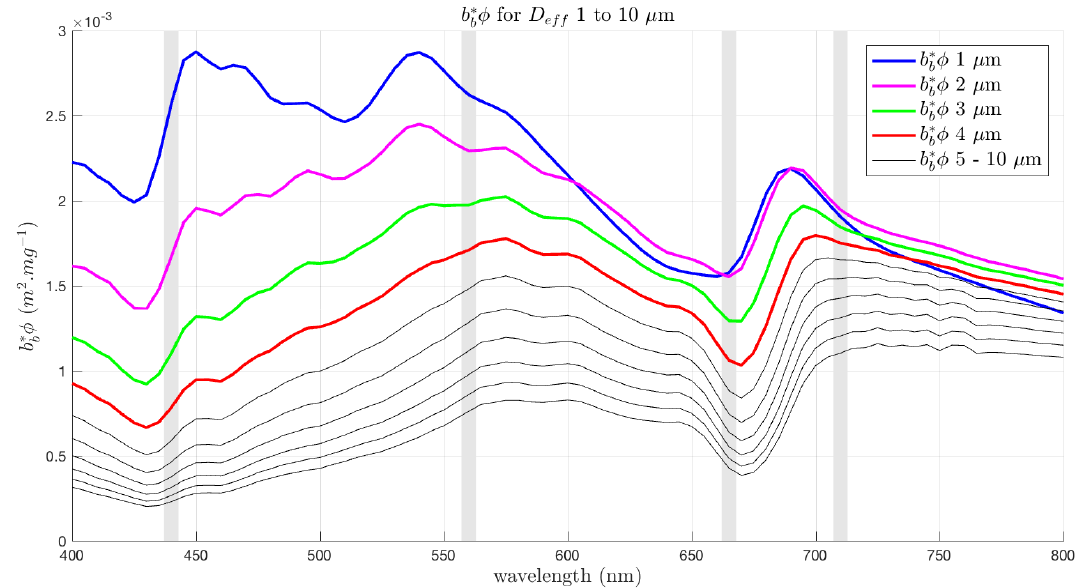
Figure 12. b ∗ φ shown for D ef f 1 to 10 µ m. The largest differences in backscatter across the spectrum b occur between 1 and 4 µ m, with the exception of the overlapping of b ∗